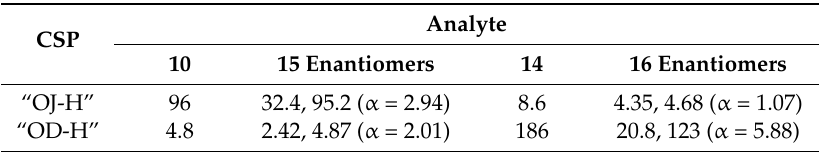
Table 3. Relative retention (k’) of 2-acetylanthracene ( 10 ), 9-acetylphenanthrene ( 14 ), and the racemic alcohols 15 and 16 derived from each.